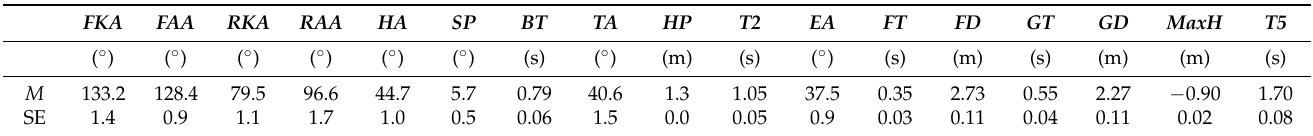
Table 2. Kinematic parameters for the rear-weighted kick start from position 3 on the OSB12 starting block—the shortest time to 5